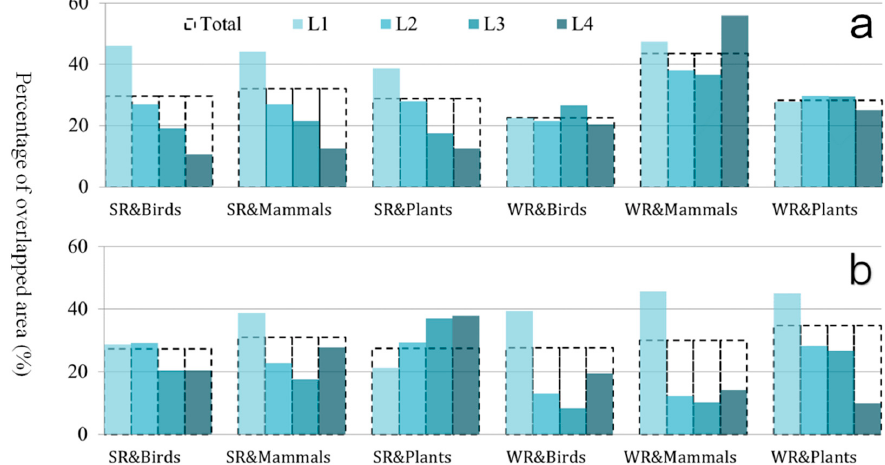
Figure 2. The spatial superposition relationship of ecosystem services and biodiversity: L4 represents the spatial overlap ratio of 10% of the most important regions for two elements. L3 represents the spatial overlap ratio of 76%–90% of the important regions for two elements. L4 represents the spatial overlap ratio of 51%–75% of the important regions for two elements. L1 represents the spatial overlap ratio of 1%–50% of the important regions for two elements. The total represents the spatial overlap of the region without level division. SR represents the soil conservation function. WR represents the water conservation function. ( a ) is the analysis at the fine scale and ( b ) is the analysis at the coarse